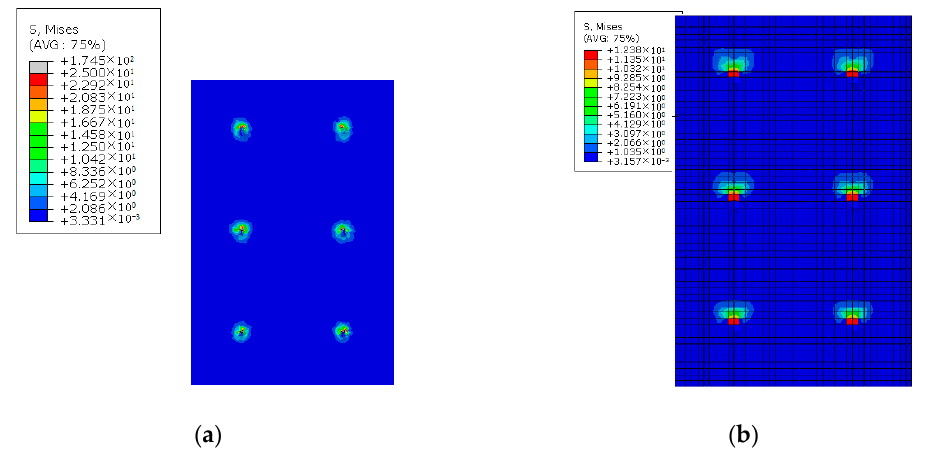
Figure 16. Stress cloud diagrams of the concrete in the middle wall panel. ( a ) Q1 wallboard; ( b ) Q2 wallboard.